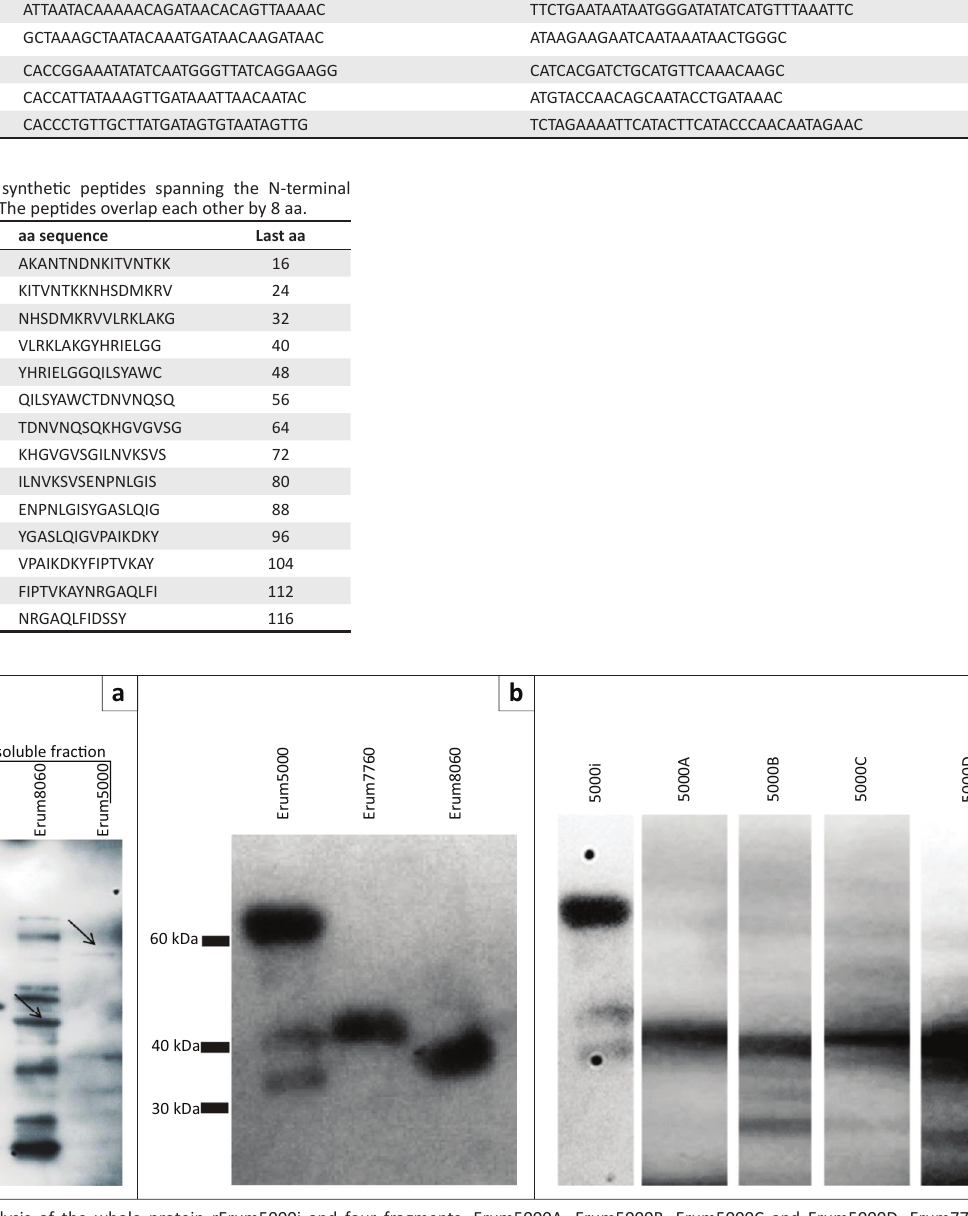
FIGURE 1-A1: Western blot analysis of the whole protein rErum5000i and four fragments, Erum5000A, Erum5000B, Erum5000C and Erum5000D, Erum7760 and Erum8060. The purified recombinant proteins are expressed and purified using Champion TM pET Directional TOPO® expression system. Recombinant proteins were detected by using (a) immune sheep sera and (b and c) anti-His